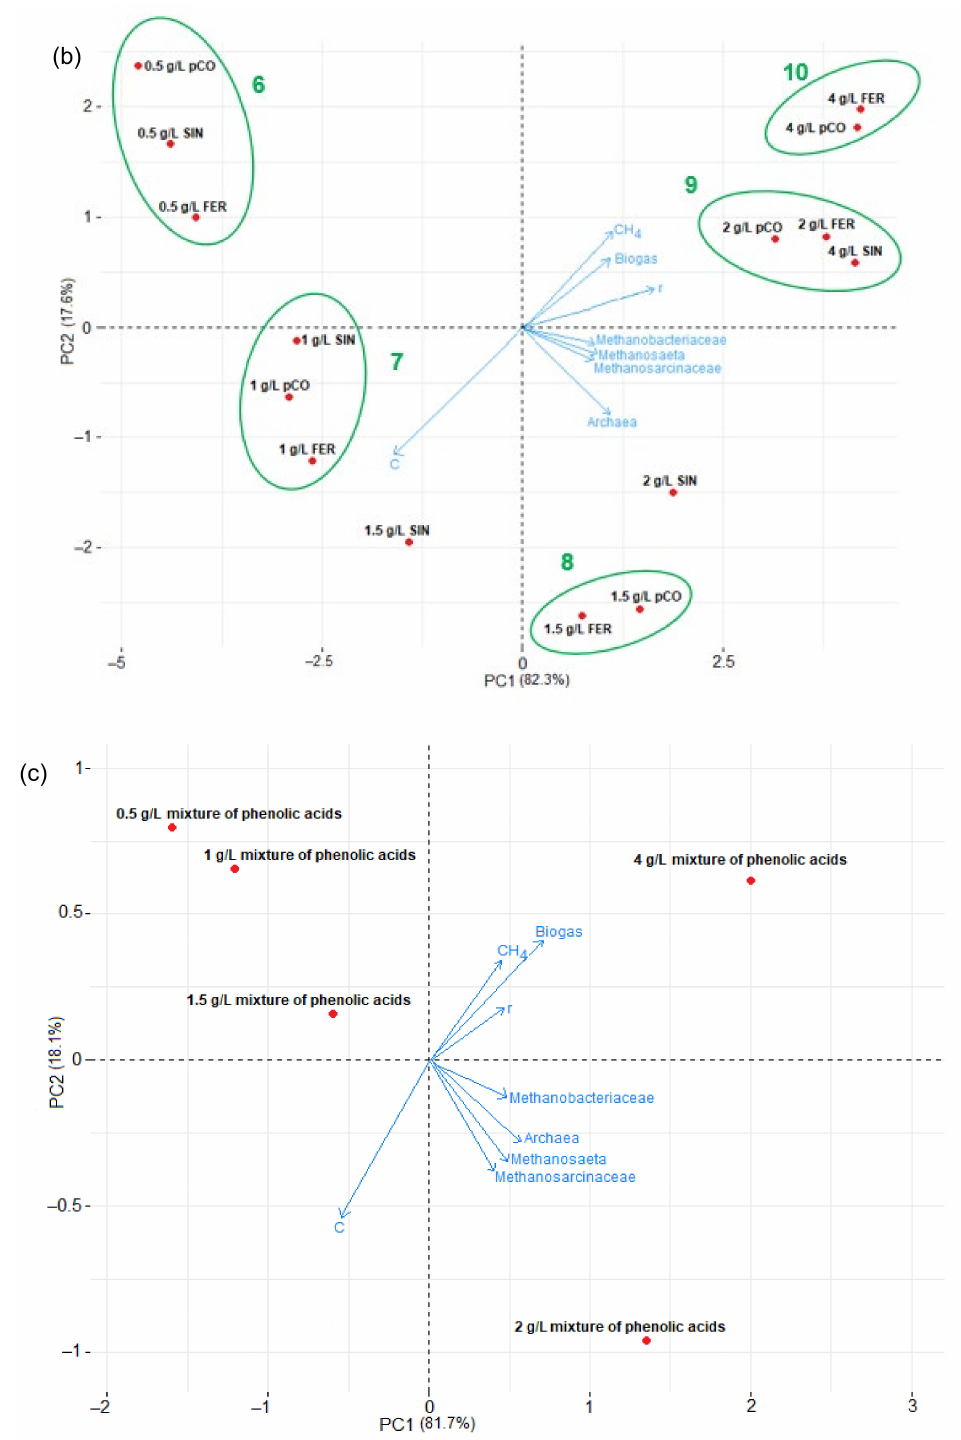
Figure 6. PCA of technological and molecular results obtained in anaerobic digestion of distillery stillage depends on the added phenolic acids; ( a ) hydroxybenzoic acids (pOH—p-OH benzoic acid, VAN—vanillic acid, SYR—syringic acid), ( b ) hydroxycinnamic acids (pCO— p -coumaric acid, FER—ferulic acid, SIN—sinapic acid), and ( c ) a mixture of phenolic acids. The red dots indicate the concentrations of compounds. The blue arrows represent the abundance of methanogens, the amount of methane and biogas, the rate of methane production (r), and the concentration of phenolic acids